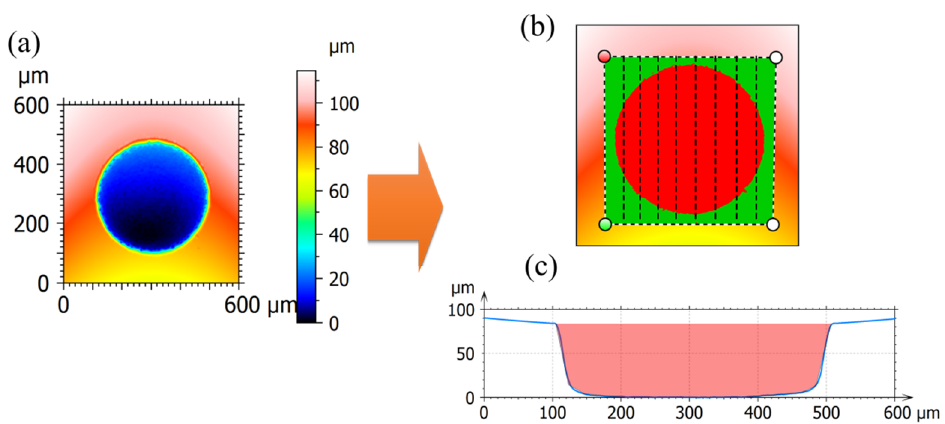
Figure 3. The calculation of the material removal volume based on the optical measurement. ( a ) the pitting topography by measurement; ( b ) A mask consisting of numerous segments to cover the pitting area; ( c ) the cross-sectional profile where the pitting volume is filled.